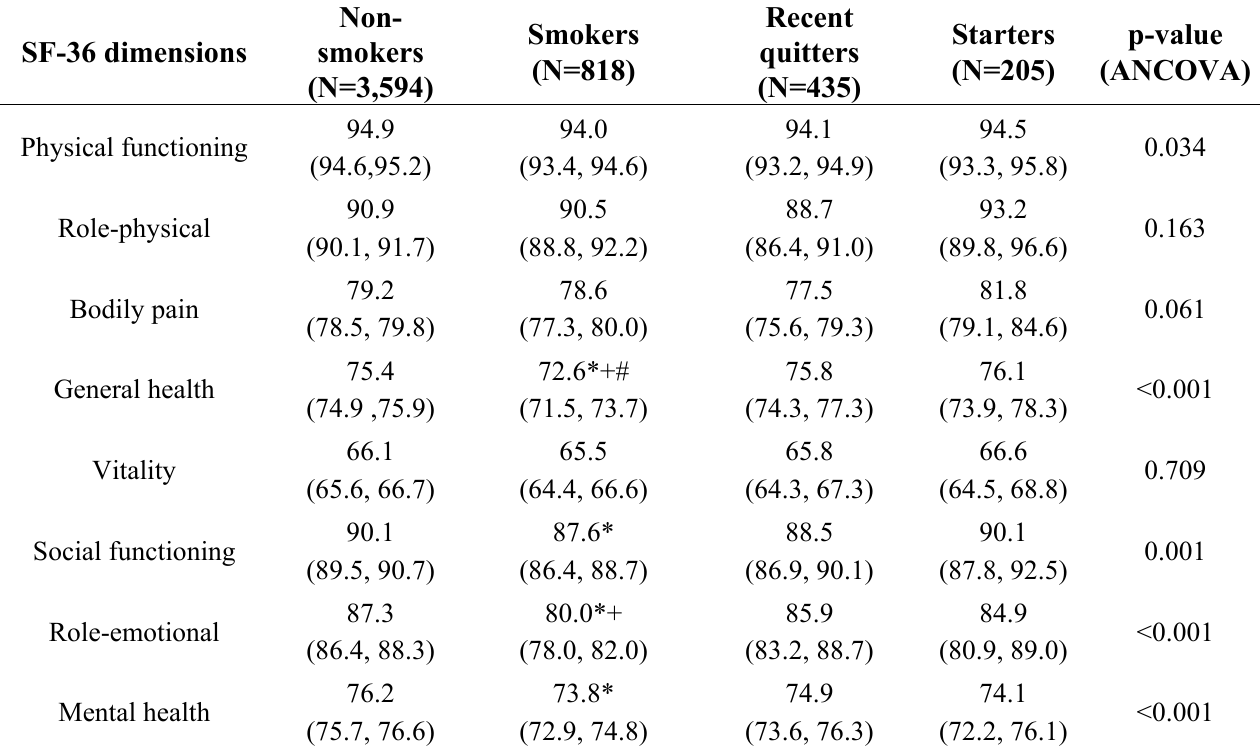
Table 3. Age and sex adjusted mean scores (95% confidence interval) on the SF-36 health status questionnaire according to changes in smoking status during